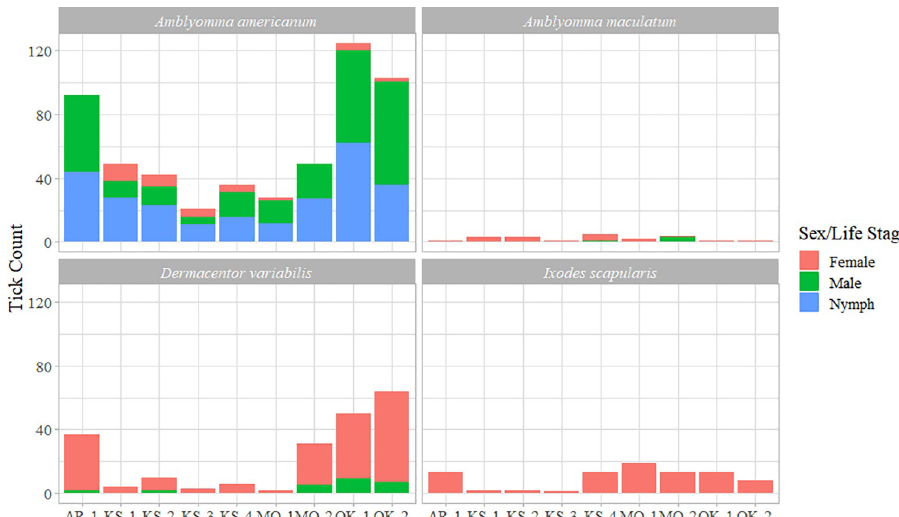
Fig 3. Ticks collected from the study region broken down by individual